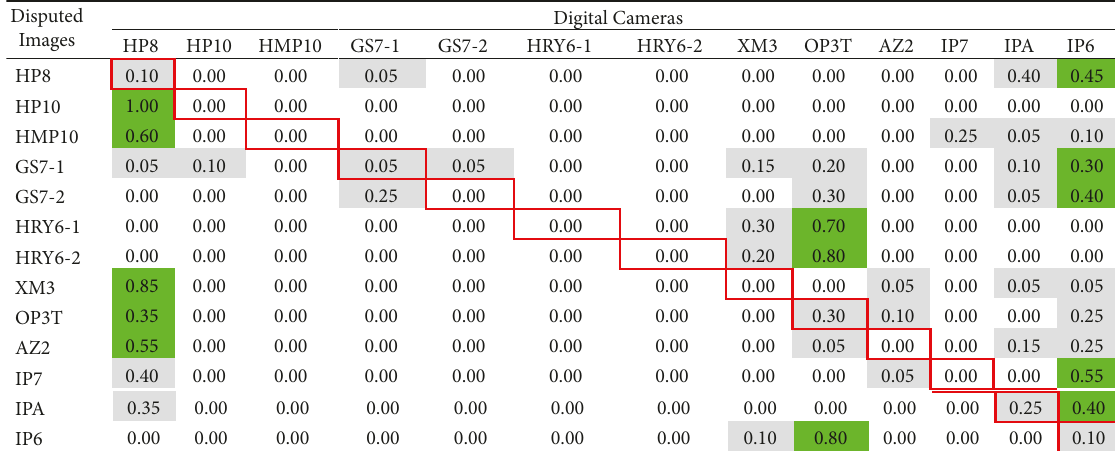
Table 5: Effectiveness of the proposed method when it is applied to the first case study (reference images are flat images, and disputed images are natural images). In this experiment, only full disputed images were